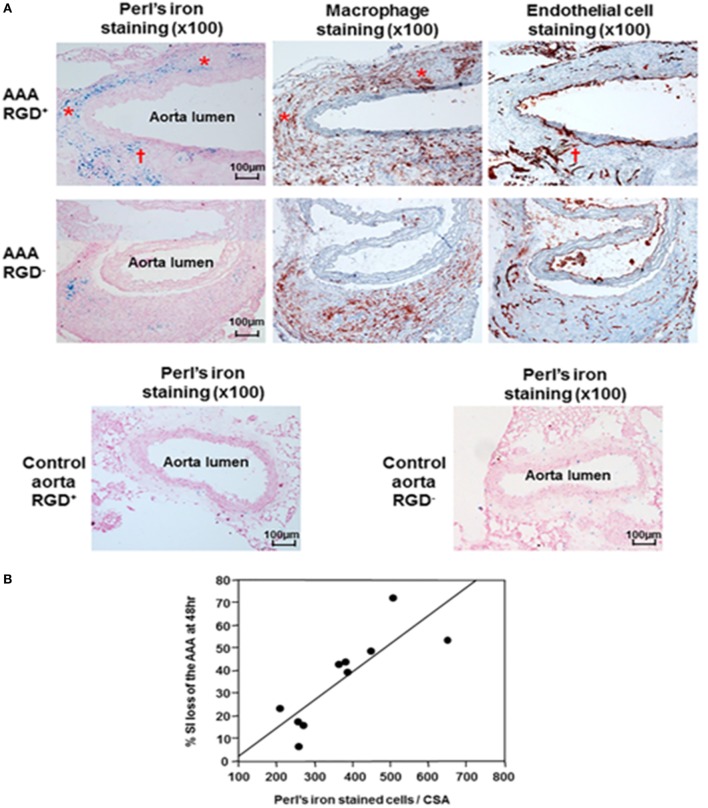
Histological analysis of abdominal aortic aneurysms and correlation with T2* signal loss on MRI. (A) Immunohistochemical AAA staining showed mural macrophage infiltration and angiogenesis within the AAA wall. Perl’s iron staining showed greater accumulation of RGD-HFn-Fe3O4 in the media and adventitia of AAA wall (AAA RGD+) compared to HFn-Fe3O4 (AAA RGD−), co-localizing with both macrophages (asterisks) and areas of angiogenesis (dagger). The control aortic wall showed minimal Perl’s iron staining in both RGD+ and RGD− groups. (B) There was a close correlation between the total number of Perl’s iron-stained cells and % signal intensity loss in the AAA (n = 10, r = 0.83, P = 0.003). Reprinted from Kitagawa et al. (30), under the terms of the Creative Commons Attribution Non-Commercial License (CC BY-NC). Abbreviations: AAA, abdominal aortic aneurysm; MRI, magnetic resonance imaging; RGD-HFn, Arg–Gly–Asp-conjugated human ferritin nanoparticle; r, Pearson’s correlation coefficient; T2*, transverse relaxation time constant.